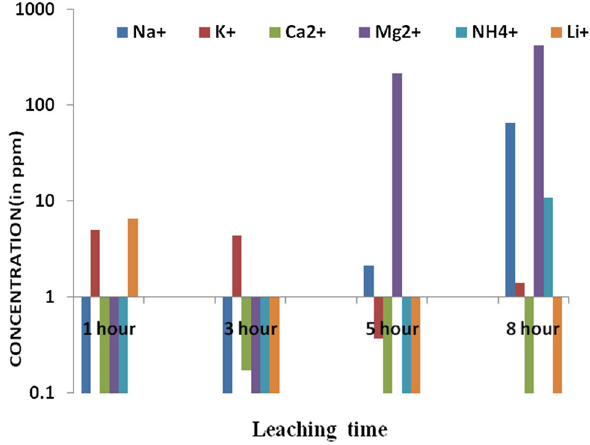
Fig. 8 Change in concentration of cations (in ppm) in aqueous leachates of Ledo coal (LC-60A) with leaching time (in hour) at 45 (cid:3) C